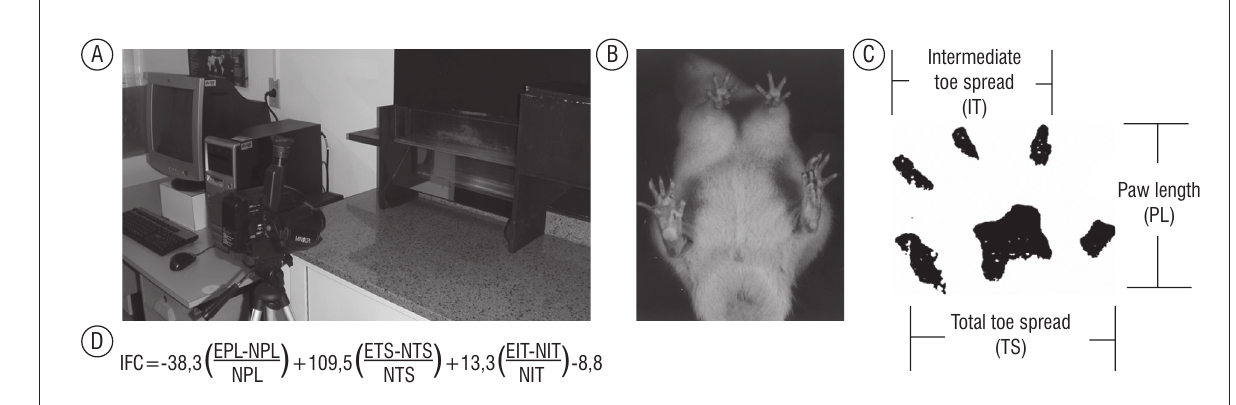
Figura 2 - Configuração do sistema (A) para a coleta das variáveis necessárias para o cálculo do IFC (C e D), onde: PL =